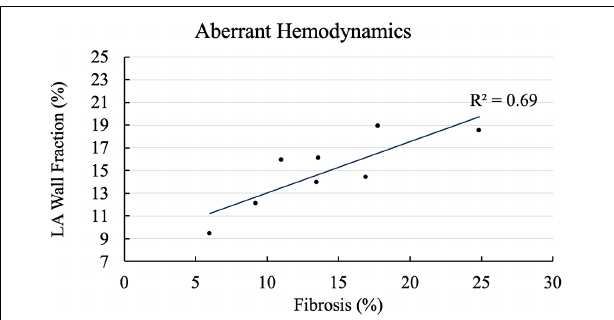
FIGURE 3 | Correlation of aberrant hemodynamics with left atrial (LA) fibrotic burden. X-axis shows cases arranged with increasing fibrosis percentage, and Y-axis plots percentage of fractional LA surface area exposed to aberrant hemodynamics at LA